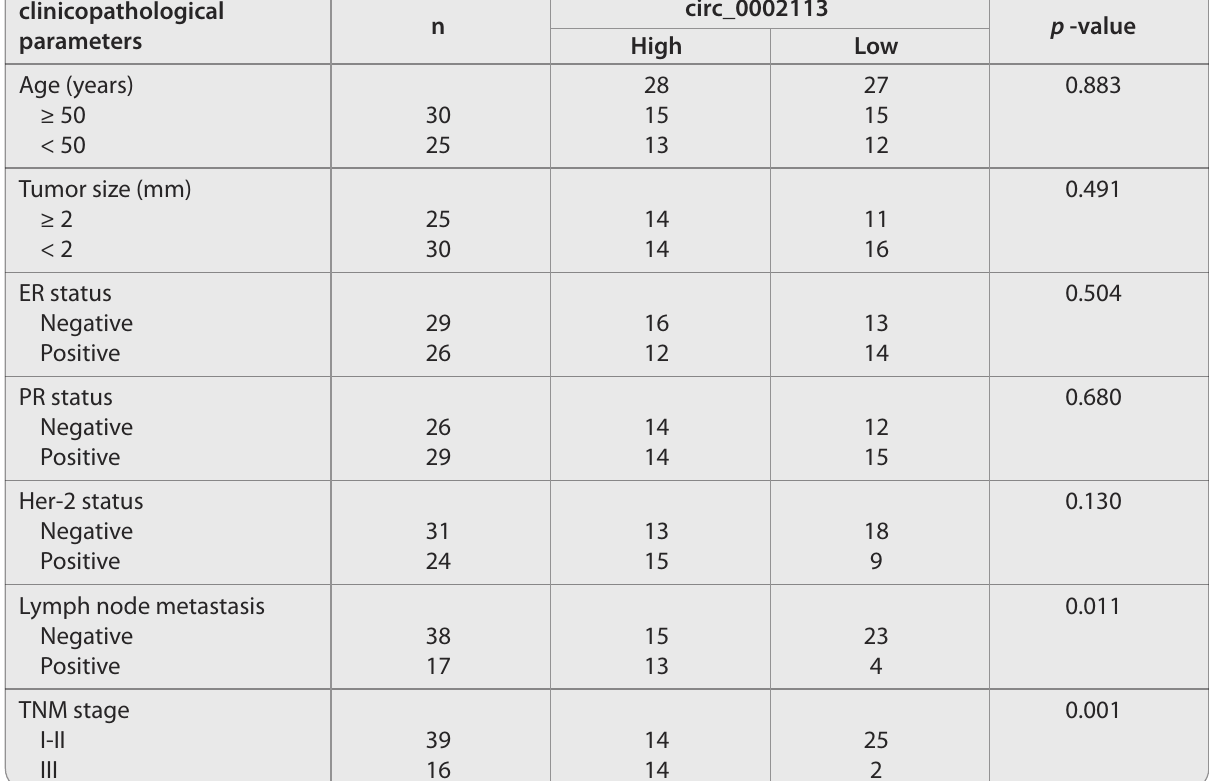
Table 1. Correlation between circ_0002113 expression and clinicopathological parameters of patients with breast